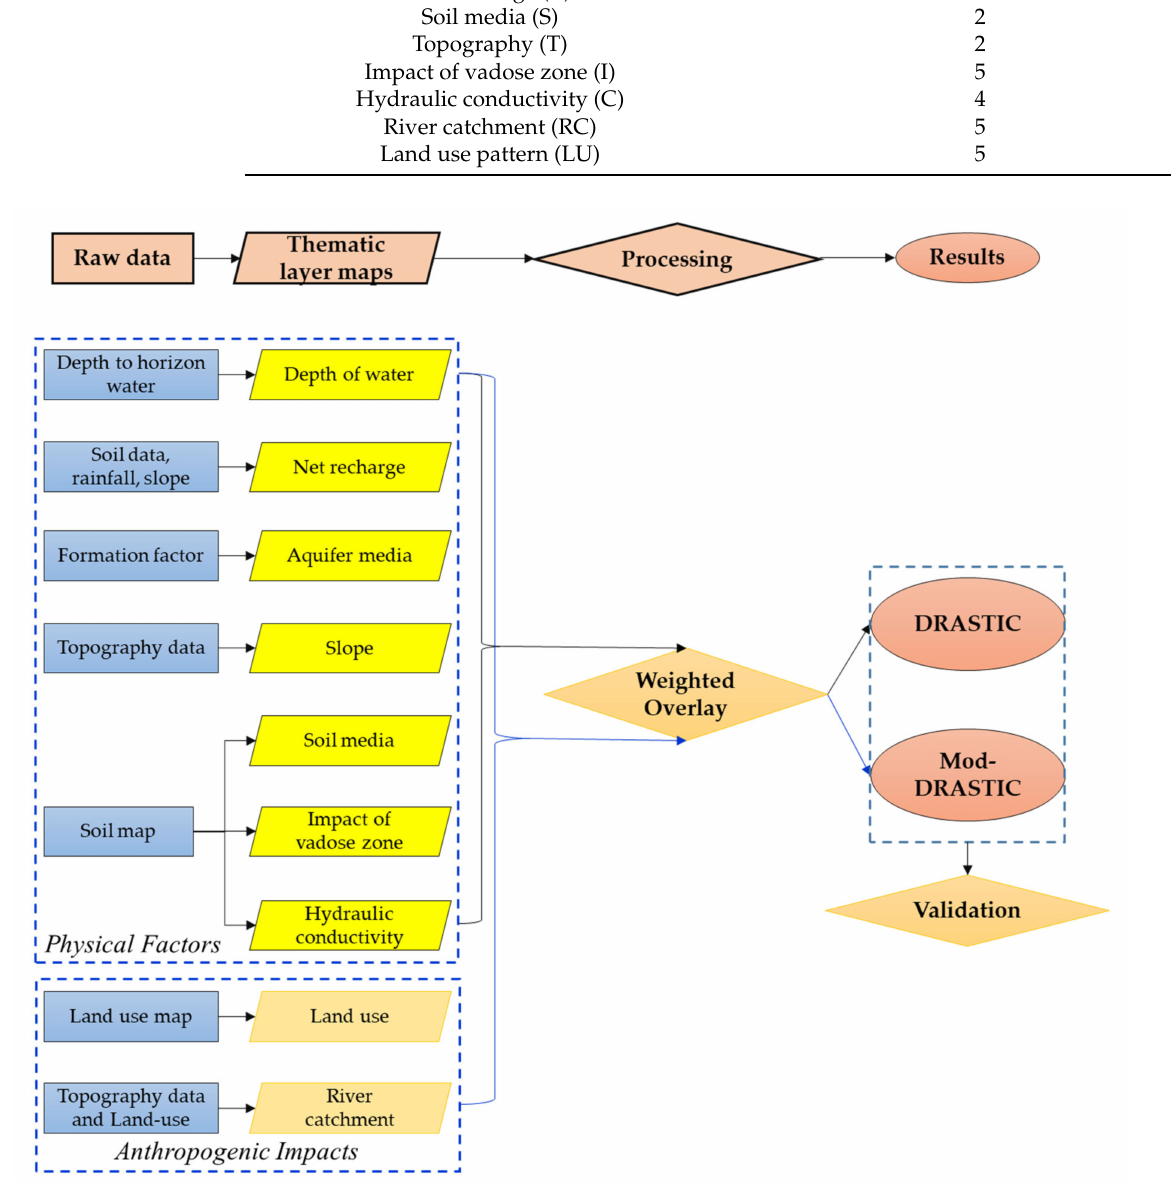
Figure 2. Flowchart of the research method used to generate soil water vulnerability maps using the generic DRASTIC and Mod-DRASTIC models. In addition to seven factors that were used in the DRASTIC model (shown in yellow), the Mod-DRASTIC model included two anthropogenic factors (shown in